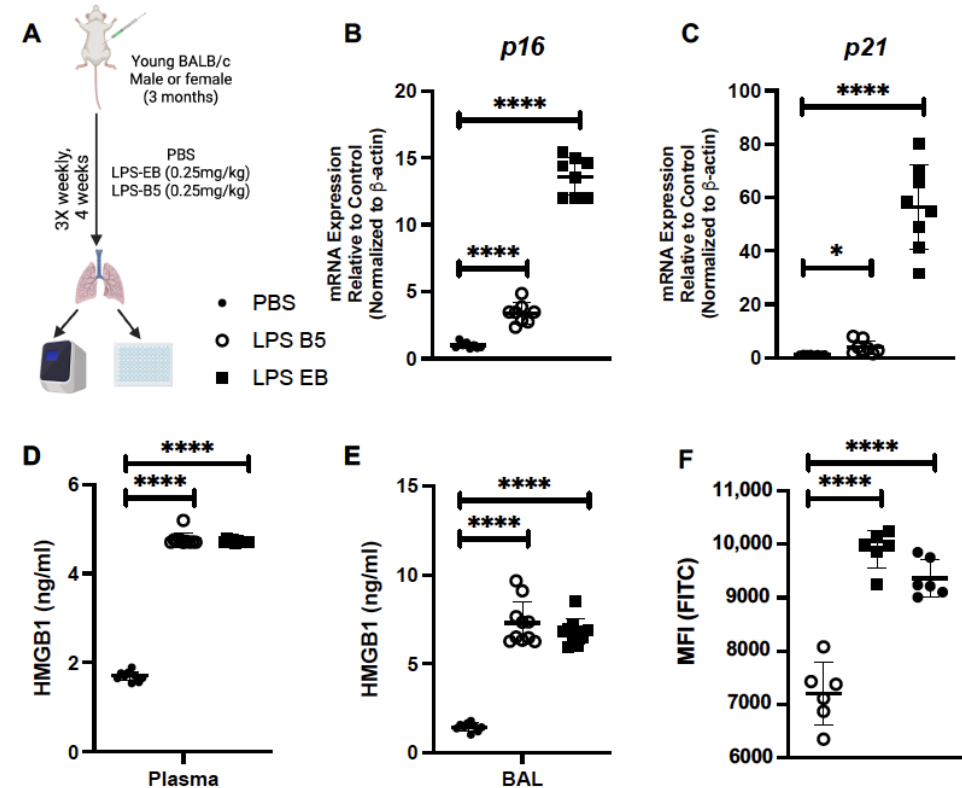
Figure 6. Treatment of Young Mice with Low-Dose LPS Induces HMGB1 Production. ( A ) Experimental layout for LPS injections in young adult BALB/c mice (3 months). Lung tissue was collected from control and treated mice. ( B , C ) p16 and p21 expression in young lung in response to low-dose LPS administration. ( D ) Plasma and ( E ) BAL was isolated and HMGB1 was assessed. ( F ) β -galactosidase hydryolysis in young lung in response to senolytic treatment was assessed by flow cytometry. N = 6 mice per group, and the experiment was repeated 3 times. * p < 0.05, **** p < 0.0001. Figure 6A was created using BioRender.